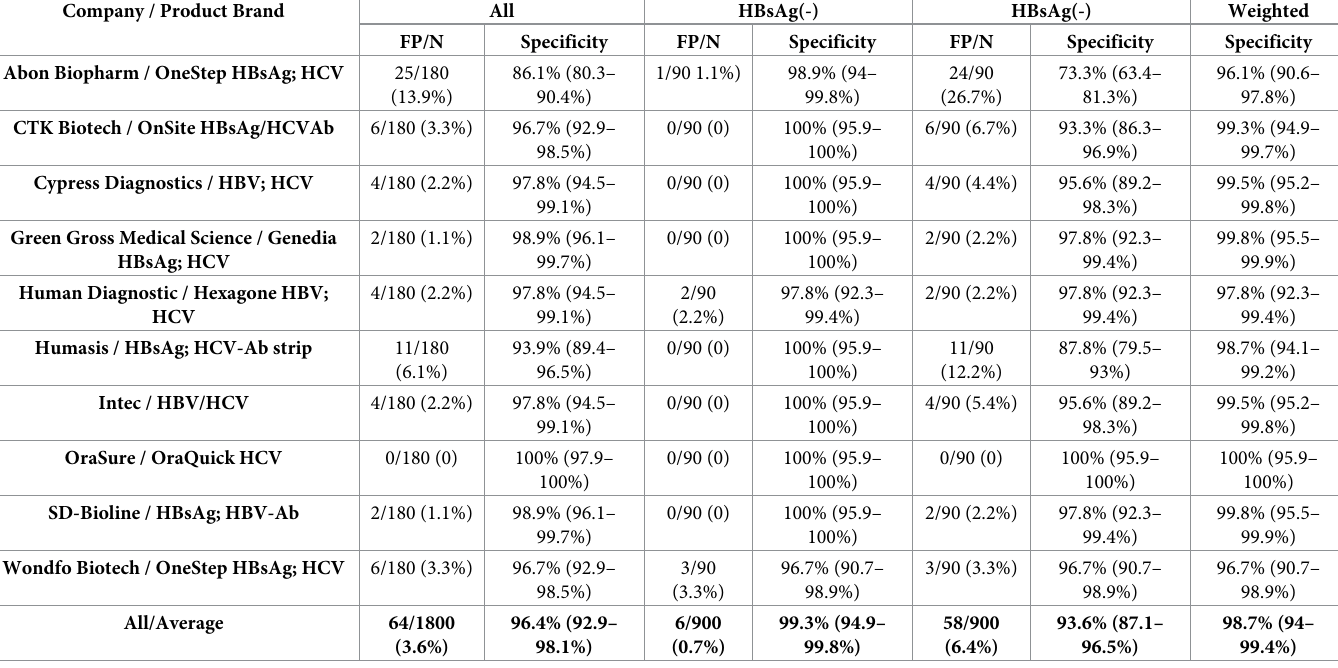
Table 5. Specificity of HCV-Ab tests among HBsAg positives and negatives. The adjusted PPV is based on an HCV prevalence of 8.5% and and HBsAg prevalence of 11%. Company / Product